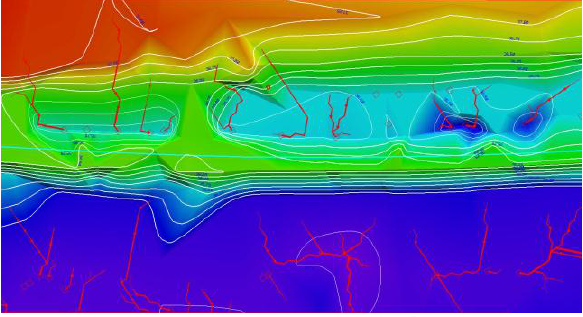
Figure 22: Drainage simulation based on RailMapper data using